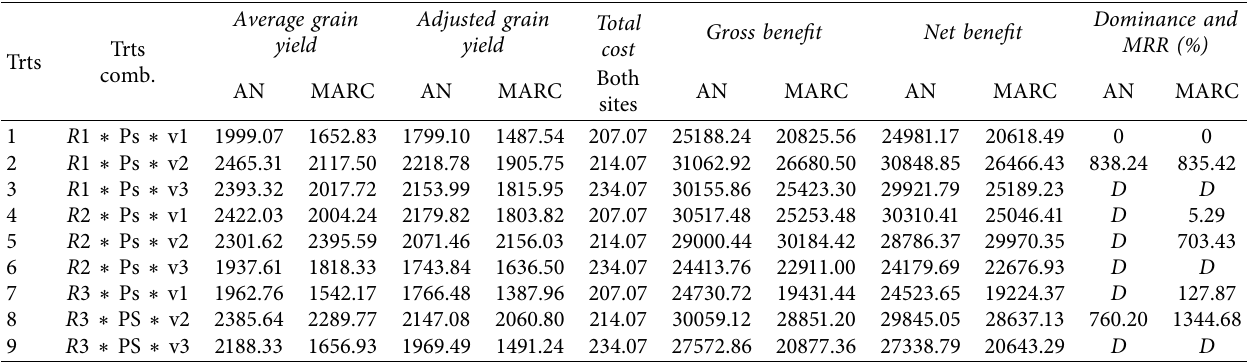
Table 6: Partial budget analysis for Arsi Negele and Melkasa Agricultural Research Center. Trts Trts